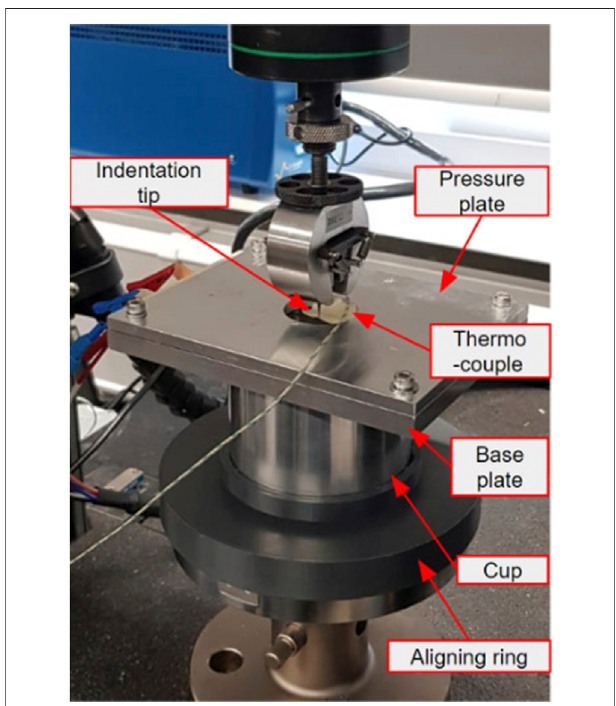
FIGURE 3 | Annotated picture of the nail penetration testing set up.